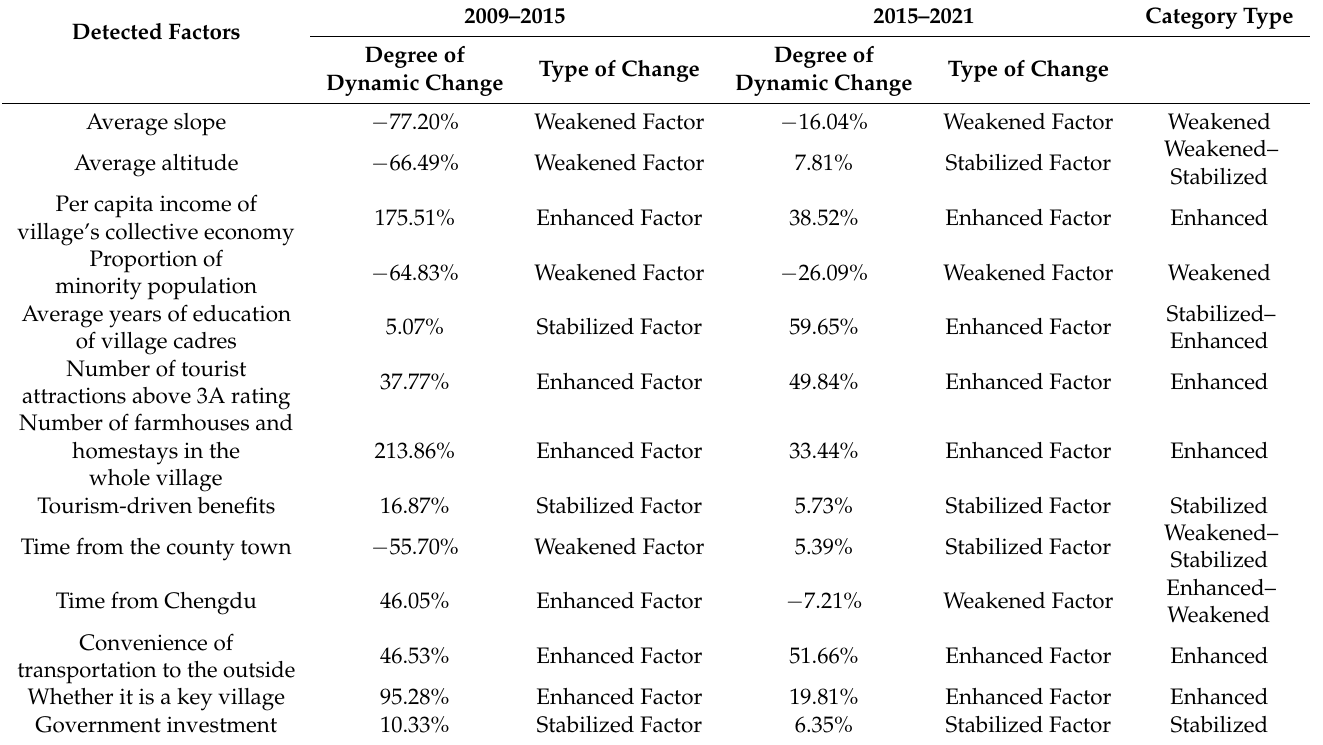
Table 4. Classification of factors affecting land use for rural tourism in the study